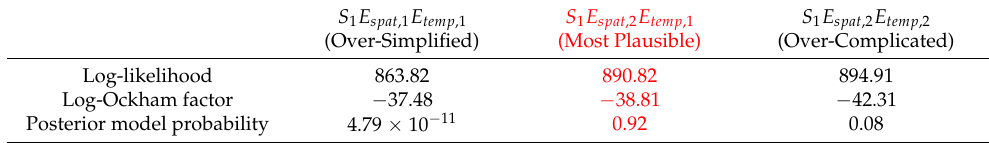
Table 6. Model class selection results (modal frequency prediction).